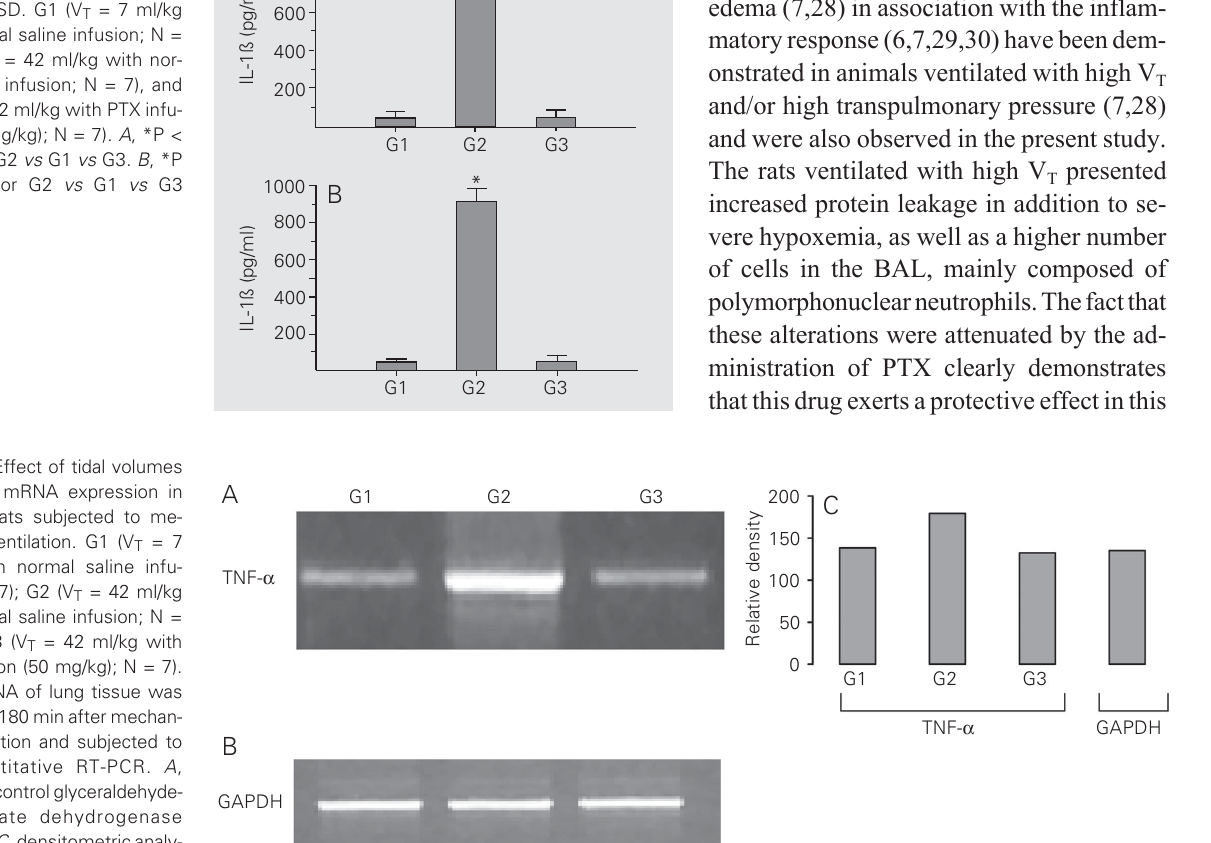
Figure 2. Effect of pentoxifylline (PTX) on IL-1ß levels in plasma (A) and bronchoalveolar lavage (B) of rats under mechanical ven- tilation. Data are reported as means ± SD. G1 (V T = 7 ml/kg with normal saline infusion; N = 7); G2 (V T = 42 ml/kg with nor- mal saline infusion; N = 7), and G3 (V T = 42 ml/kg with PTX infu- sion (50 mg/kg); N = 7). A , *P < 0.001 for G2 vs G1 vs G3. B , *P < 0.001 for G2 vs G1 vs G3 (ANOVA).